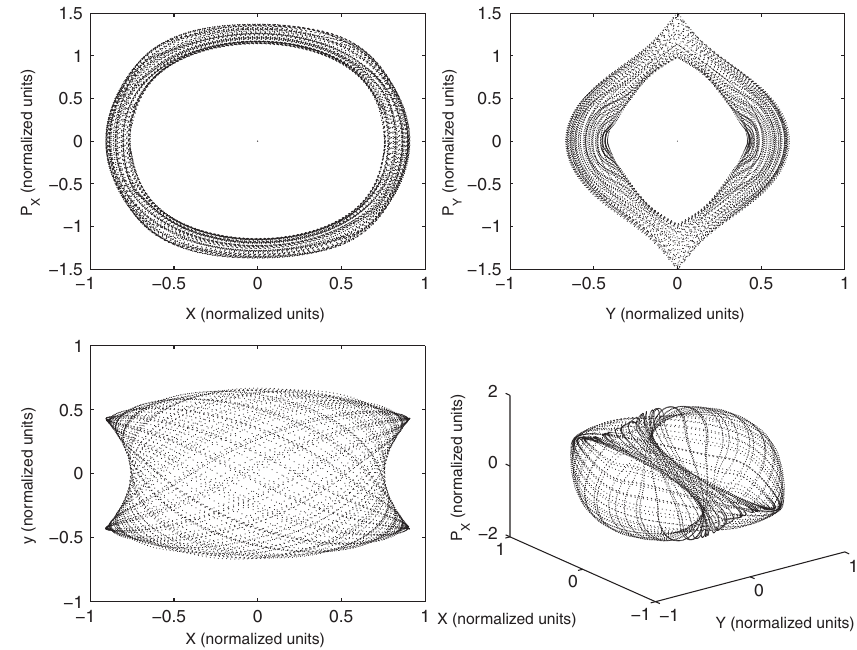
FIG. 2. Two-dimensional projections of a four-dimensional elliptical-type integrable motion [horizontal phase space (left top), vertical phase space (right top), and x - y projection (left bottom)] and the three-dimensional trajectory surface in p ¼ 0 : 1 , y ¼ 0 : 42 , p ¼ 0 : 1 , E (cid:3) 1 : 91 , and (cid:1) (cid:3) 1 : 96 The initial conditions are x ¼ 0 : 9 , p x y